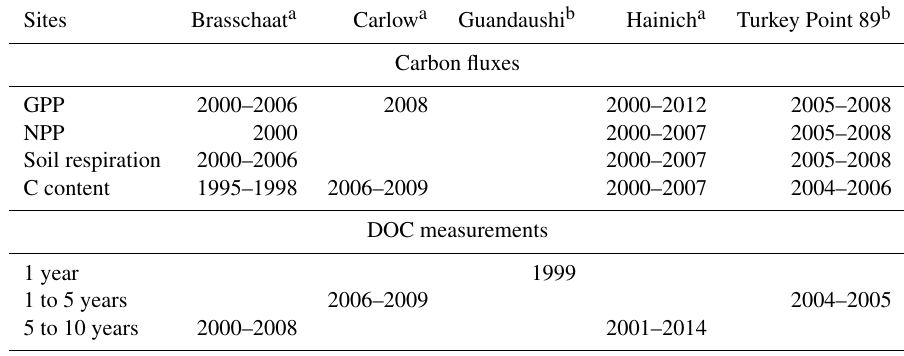
Table 3. Data availability for model evaluation at different sites.